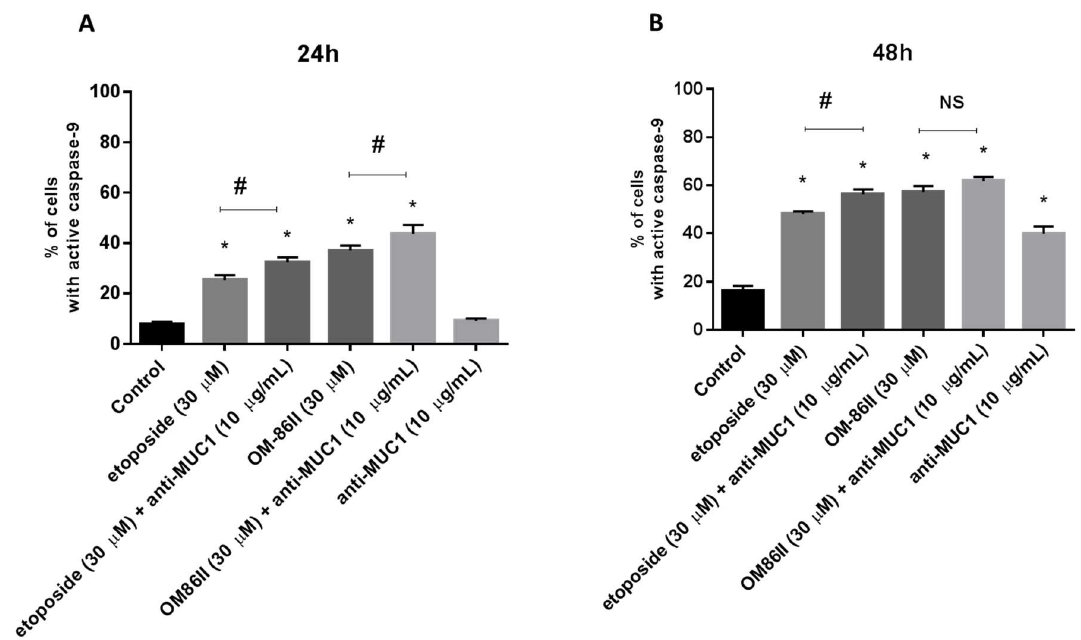
Figure 6. Caspase-9 activity in AGS gastric cancer cells treated for 24 h ( A ) and 48 h ( B ) with anti-MUC1 (10 µg/mL), OM-86II (30 µM), OM-86II + anti-MUC1 (30 µM + 10 µg/mL), etoposide (30 µM) and etoposide + anti-MUC1 (30 µM + 10 µg/mL) was demonstrated using flow cytometry. Mean percentage values from three independent experiments ( n = 3), performed in duplicate, are presented. * p < 0.05 vs. control group; # p < 0.05. MUC1, mucin-1; OM-86II, octahydropyrazin[2,1-a:5,4-a′]diisoquinoline derivative; ns, not significant.